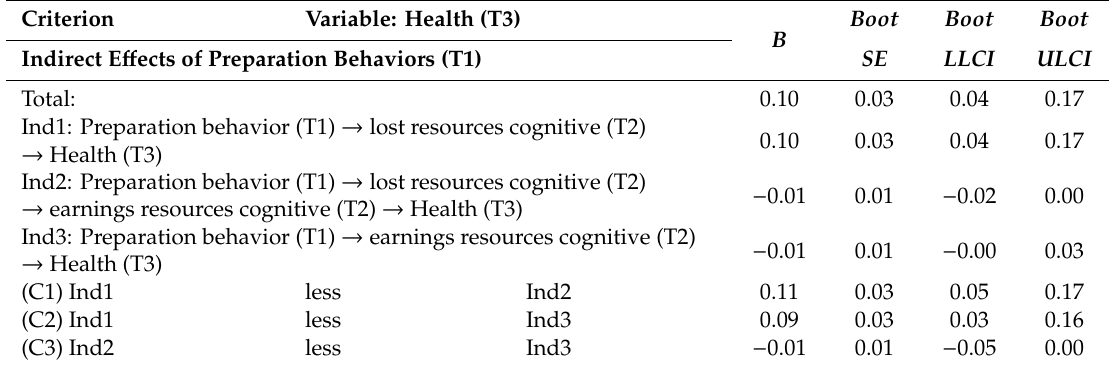
Table 9. Comparison of the indirect effects of preparation behaviors (T1) through the losses (T2) and gains of cognitive resources (T2) in the prediction of health (T3).